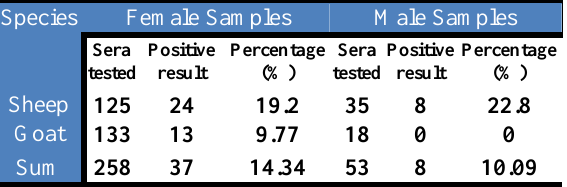
Table, 5: Percentage of sheep and goat brucellosis by using mRBT according to gender .